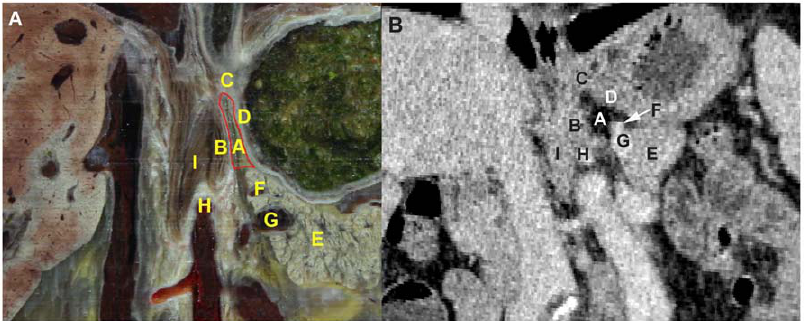
Figure 8. Presentation of the triangular-shaped LES on coronal MPR images from the front. (A, B) Visualization of the LES on CVH2 and CT images, respectively. A: LES; B: left crura of the diaphragm; C: gastric cardia; D: gastric fundus; E: pancreas; F: splenic artery; G: splenic vein; H: root of the celiac trunk; I: right crura of the diaphragm.